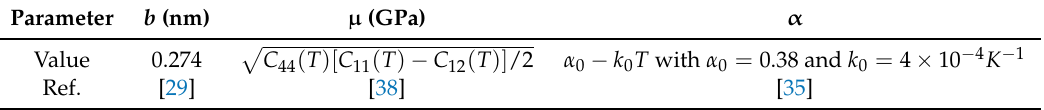
Table 2. Material properties for single crystal W with temperature